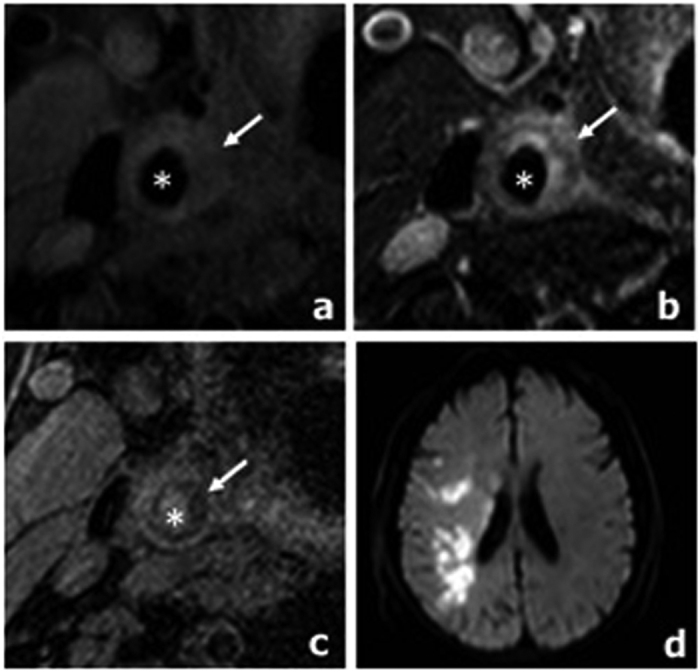
Representative MR images of a subject with high level HbA1c (HbA1c = 7.8%).(a–c) An atherosclerotic plaque with large LRNC (arrow) is detected in the right carotid artery (star): iso-intensity on T1-weighted image (a); hypointensity on corresponding T2-weighted image (b); hypo-intensity on MP-RAGE image (c). (d) Cerebral DWI demonstrates ACIs (hyperintensity) at right hemisphere.